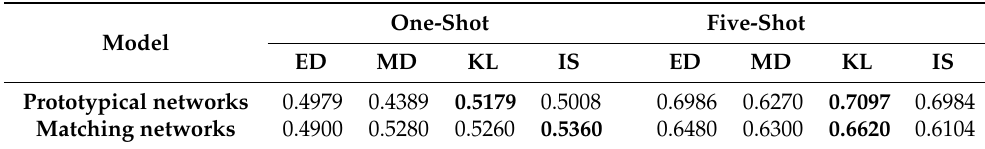
Table 2. Results for Experiment I (Mini-ImageNet). ED: Euclidean distance, MD: Mahalanobis distance, KL: KL-divergence, IS: IS-divergence. One-Shot Model